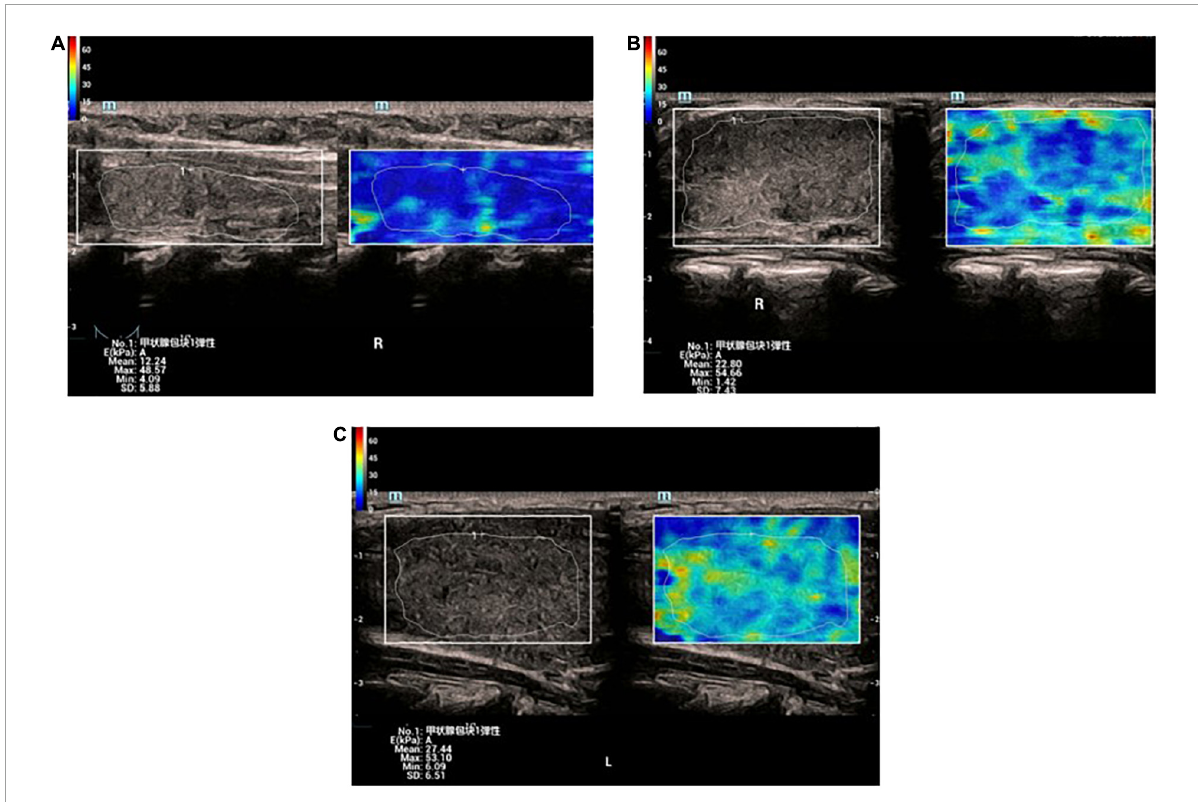
FIGURE3 (A) Elastic image of normal thyroid: the sampling area is mainly blue, indicating that the gland is soft. The hardness increases gradually from blue-green-yellow-red. (B) Elastic image of Graves’ disease: the lesion area is mixed with blue and green. (C) Elastic image of Graves’ disease: the lesion area is mixed with blue and